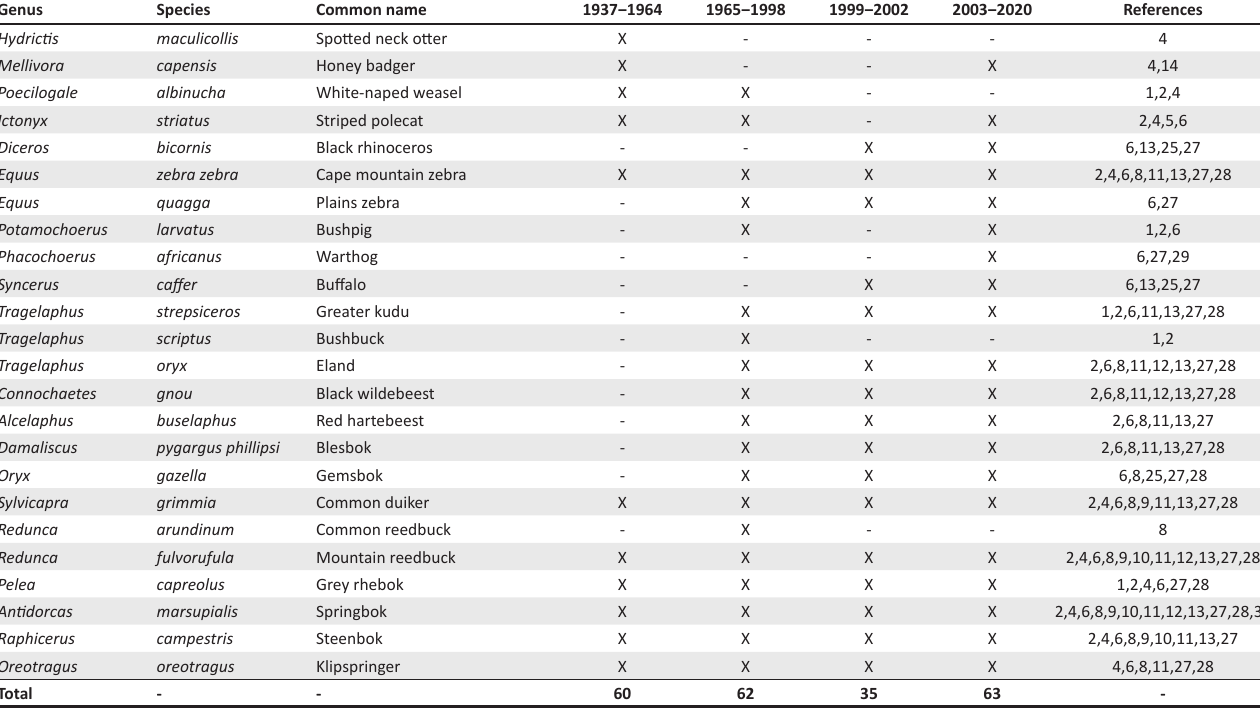
TABLE 1 (Continues...): The mammal species recorded at Mountain Zebra National Park between 1937 and 2020.